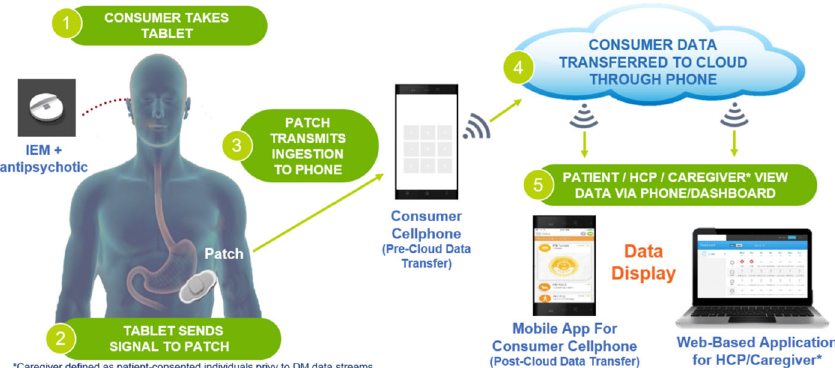
Fig. 1 Schematic of the digital medicine system (DMS). The DMS consists of an ingestible sensor embedded within a tablet of aripiprazole. The sensor logs an ingestion by communicating with a torso-worn patch. In addition to recording ingestion events, the patch also contains an accelerometer and ECG. Data are sent from the patch to a smartphone app and stored on a cloud server where it can be accessed by patients or designated caregivers.